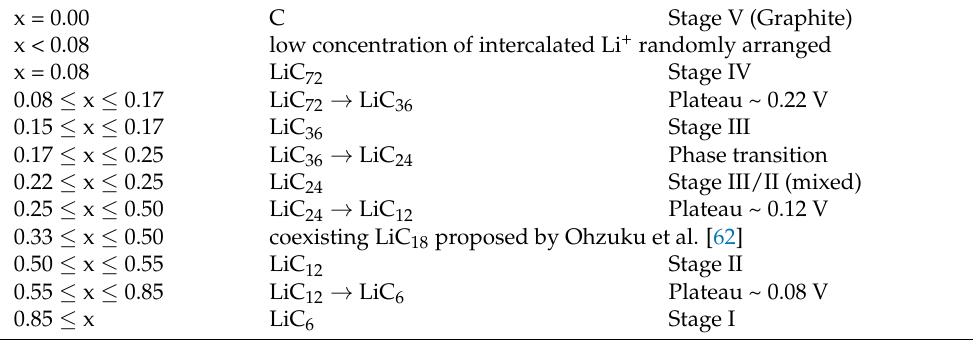
Figure 6. VOC vs. Li/Li + of the Li x C 6 (0 ≤ x ≤ 1) with highlighted crystallographic phases of Li x C 6 [31,54,56]. Adapted with permission from [22], Elsevier, 2011. Table 3. Look-up table of crystallographic phases and phase transitions of Li x C 6 for 0 ≤ x ≤ 1. x = 0.00 C Stage V